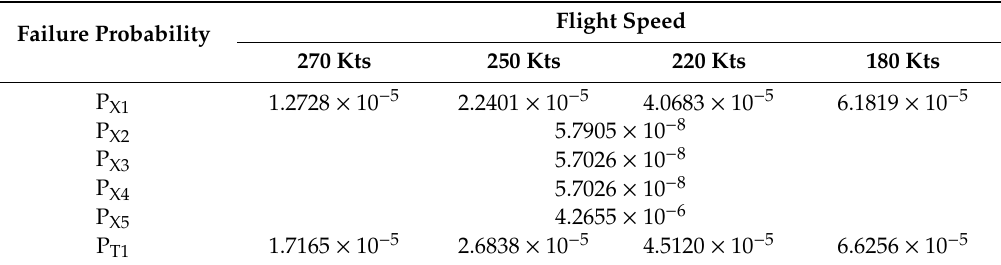
Table 4. Failure probability of bottom events in fault